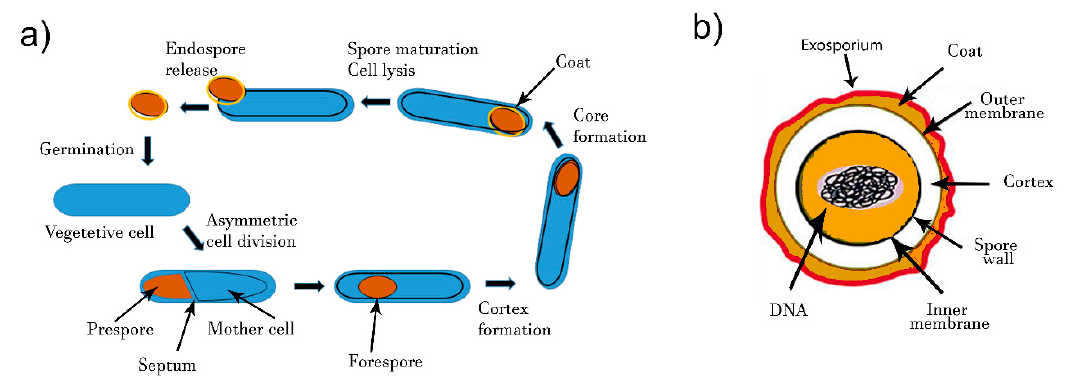
Figure 1. ( a ) Formation of spores by endospore-forming B. cereus . Upon unfavorable environmental conditions, the vegetative cell di ff erentiates and enables spore morphogenesis. Mature spores are released and will germinated to give rise to a vegetative cell under favorable conditions. ( b ) Schematic diagram of bacterial spore structure.